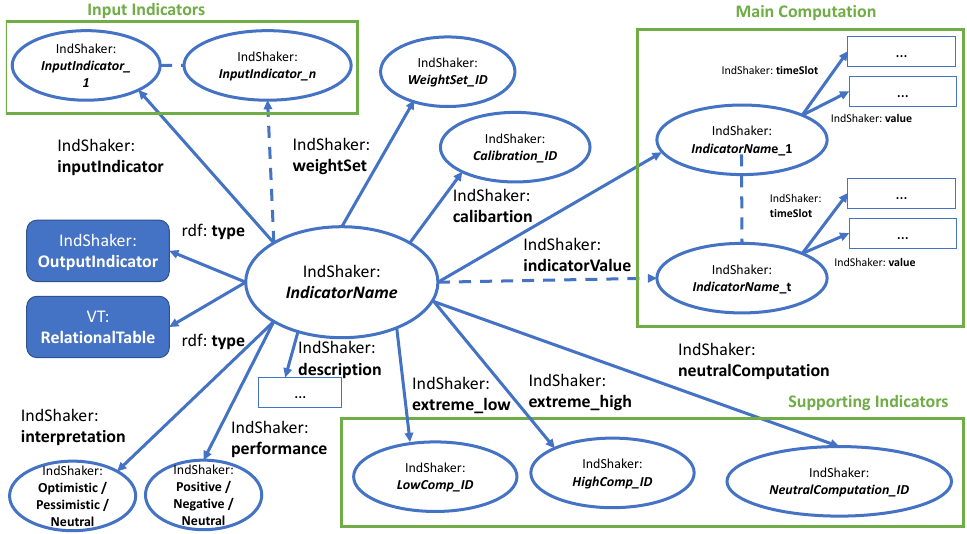
Figure 10. Ontological structure describing the